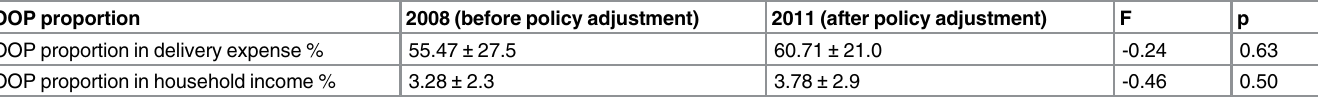
Table 5. Differences in OOP proportion between 2008 and 2011 by covariance